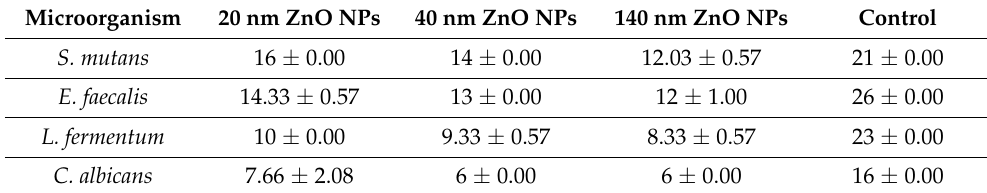
Table 2. Diameters of zones of growth inhibition of microorganisms, mm.